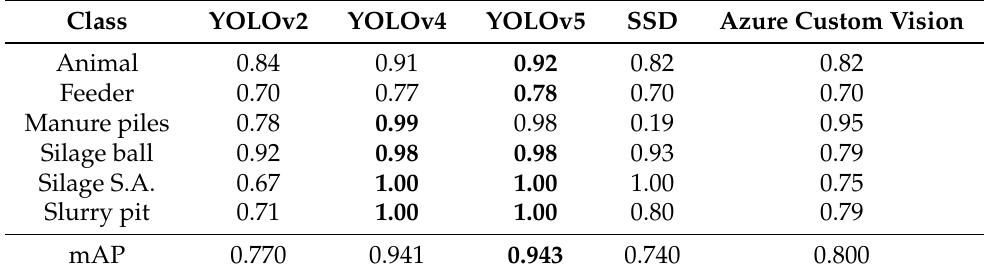
Table 5. Average Precision (AP@.5) obtained for each evaluated object detection